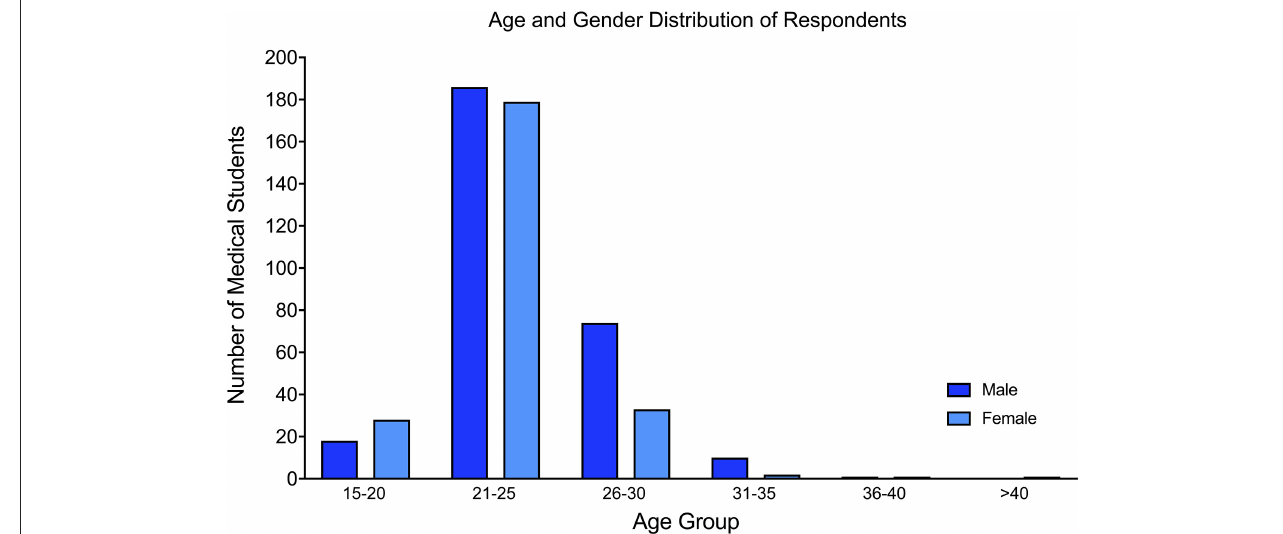
FIGURE 1 | Bar chart showing the age and gender distribution of the participants.